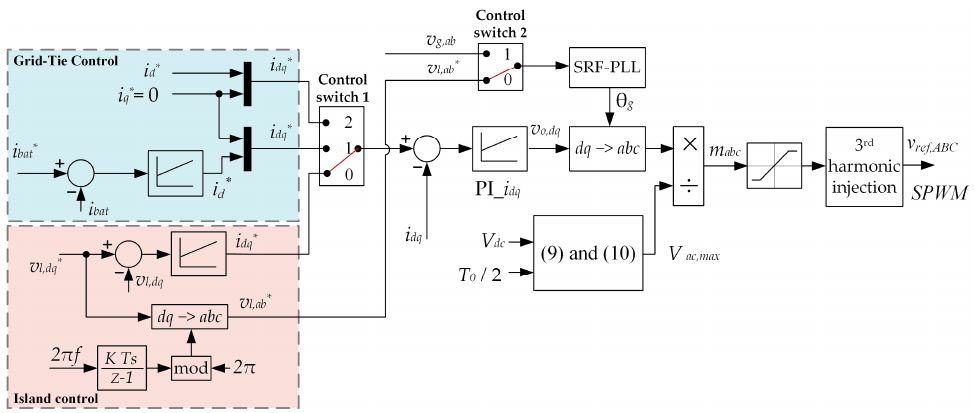
Figure 12. Block diagram of the grid-tie and island control algorithms.